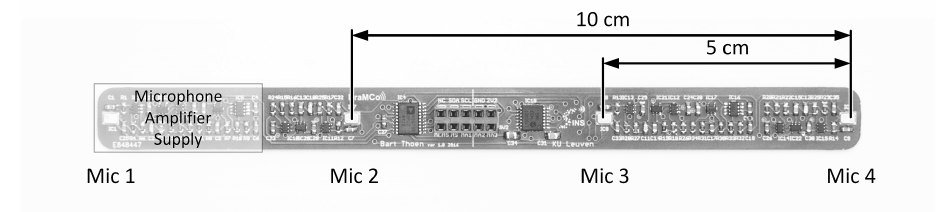
Figure 4. Picture of the linear microphone array with four MEMS microphones spaced 5cm apart [27].